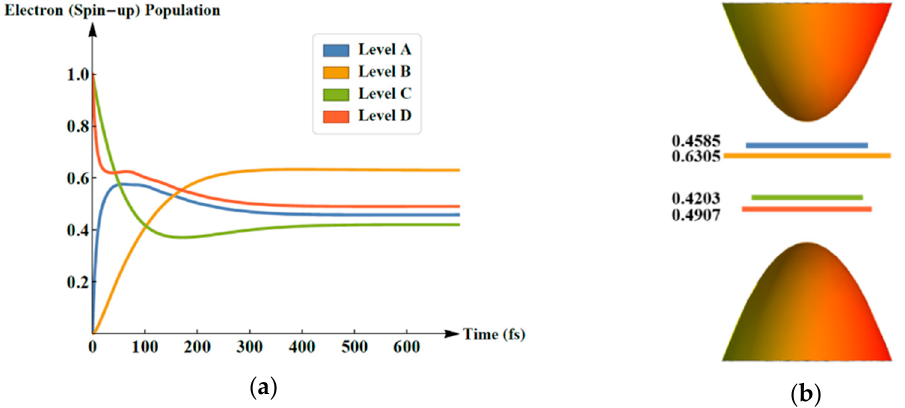
Figure 2. ( a ) Evolution of the electron (spin-up) population within 600 fs; ( b ) final stable population distributions.